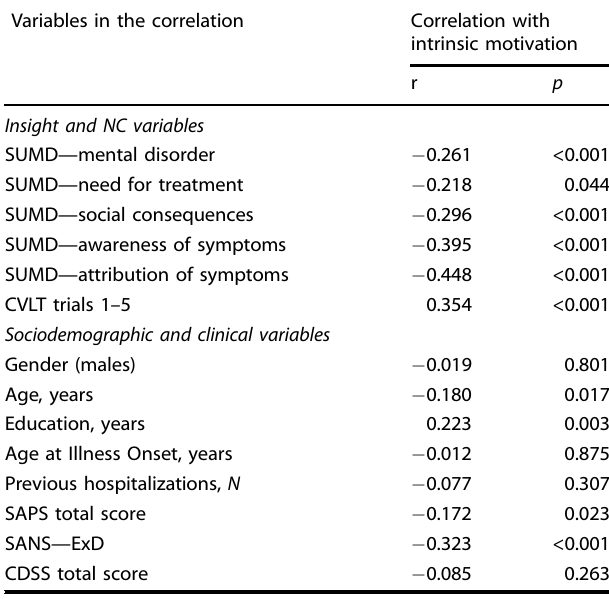
Table 2. Correlations between insight, NC, sociodemographic, and clinical variables and intrinsic motivation ( n =